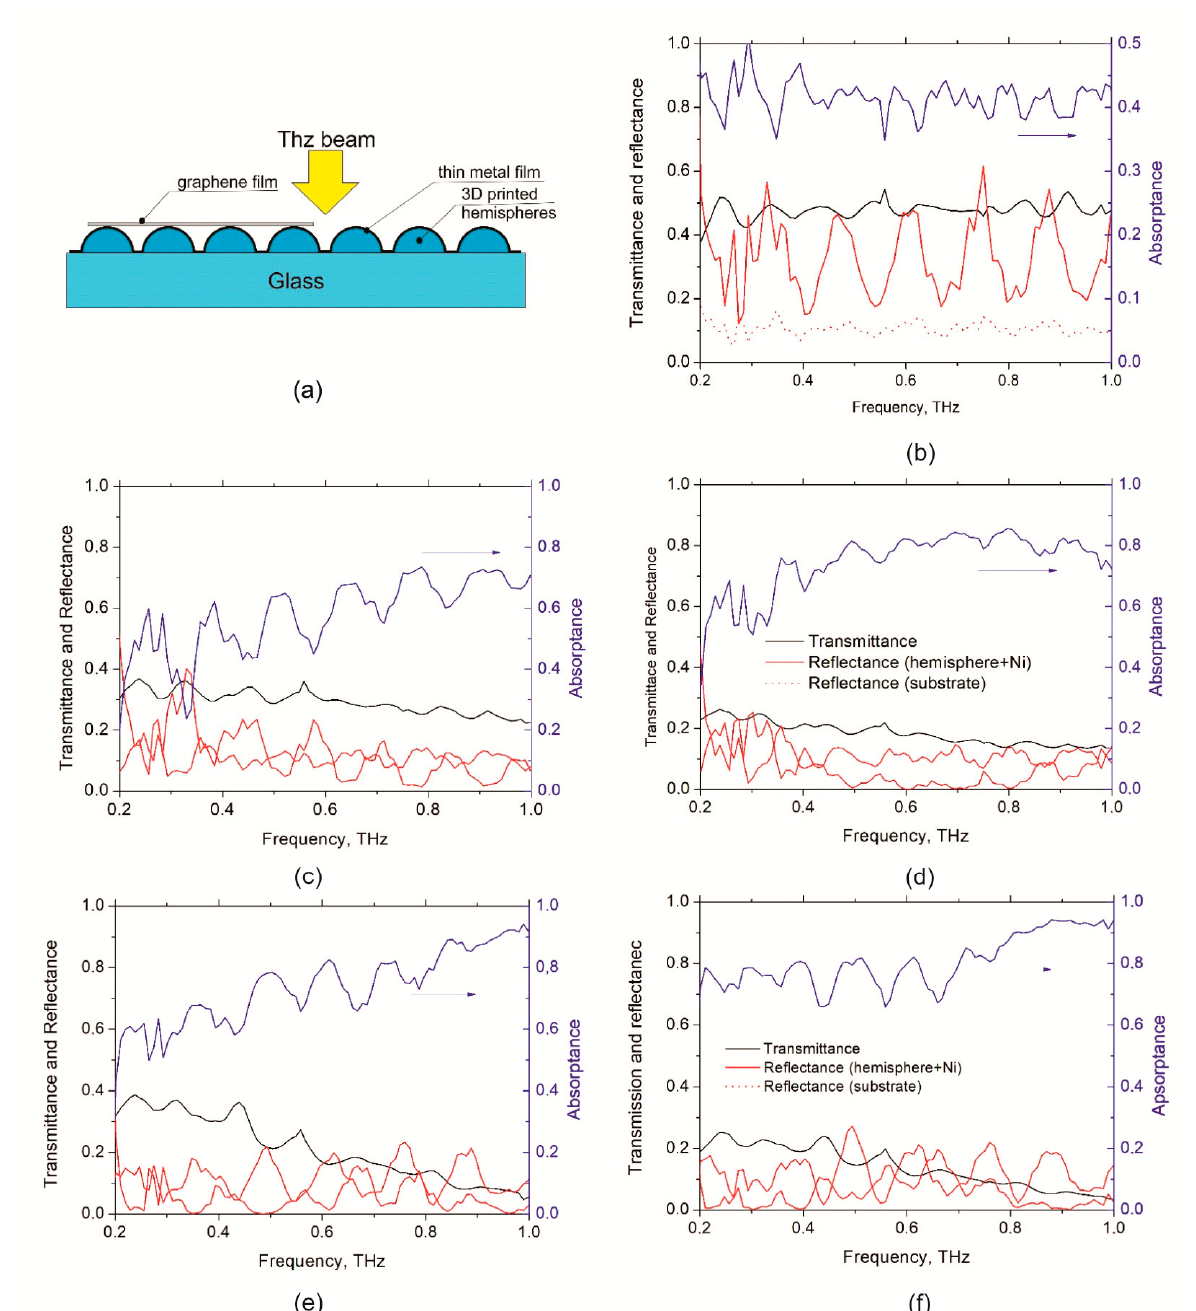
Figure 4. ( a ) Schematic presentation of the experiment. ( b ) Transmittance ( T ), reflectance ( R ) and absorptance ( A ) spectra of the 30 nm thick Ni film deposited on plane SiO 2 substrate; ( c , e ) show T , R and A spectra of SiO 2 \ polymer hemispheres \ nickel structures composed of hemispheres having diameters 300 µ m and 440 µ m, respectively; ( d ) and ( f ) show the same spectra for SiO 2 \ polymer hemispheres \ nickel \ graphene structures. Figure 4c,e show the measured spectra of the transmittance, reflectance and recon- structed absorptance ( A ) of the fabricated Ni/polymer hemispheres/substrate metasur- faces, whereas Figure 4d,f present the electromagnetic response of graphene/Ni/polymer hemispheres/substrate structures. The spectra for Ni layer, 30 nm thick, deposited on silica substrate are presented for comparison (Figure